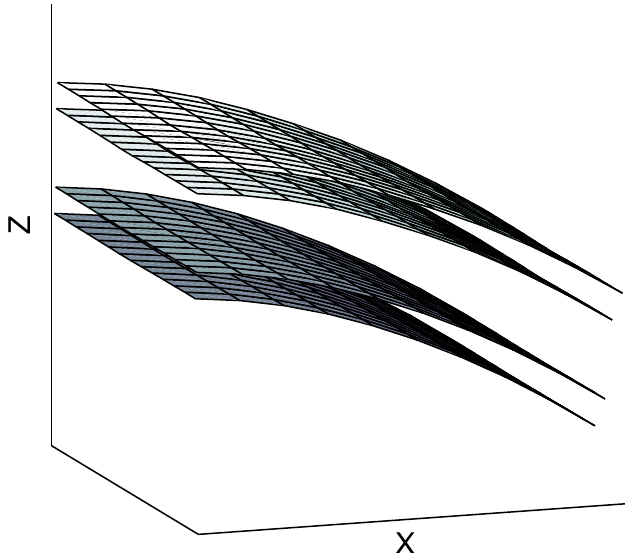
Figure 4. The computed real part of the propagating first flexural wave mode shape. The corresponding depicted wavenumber in the x direction is k